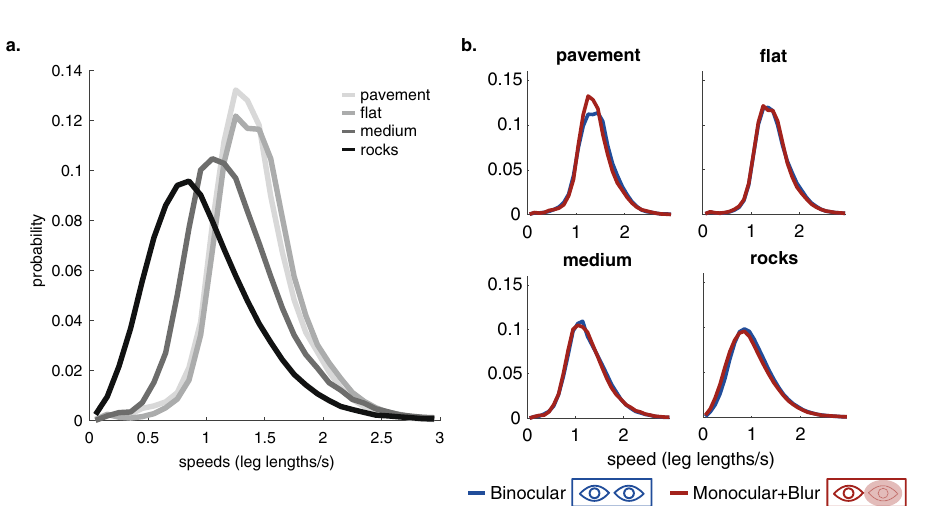
Figure 5. Walking speeds are slower in rough terrains but there is not a consistent difference in walking speeds across the binocular and blur conditions. ( a ) Walking speed distributions for the different terrains measured in leg length/s. ( b ) Walking speed distributions for normal (blue) and blur (red) conditions, for each of the terrain